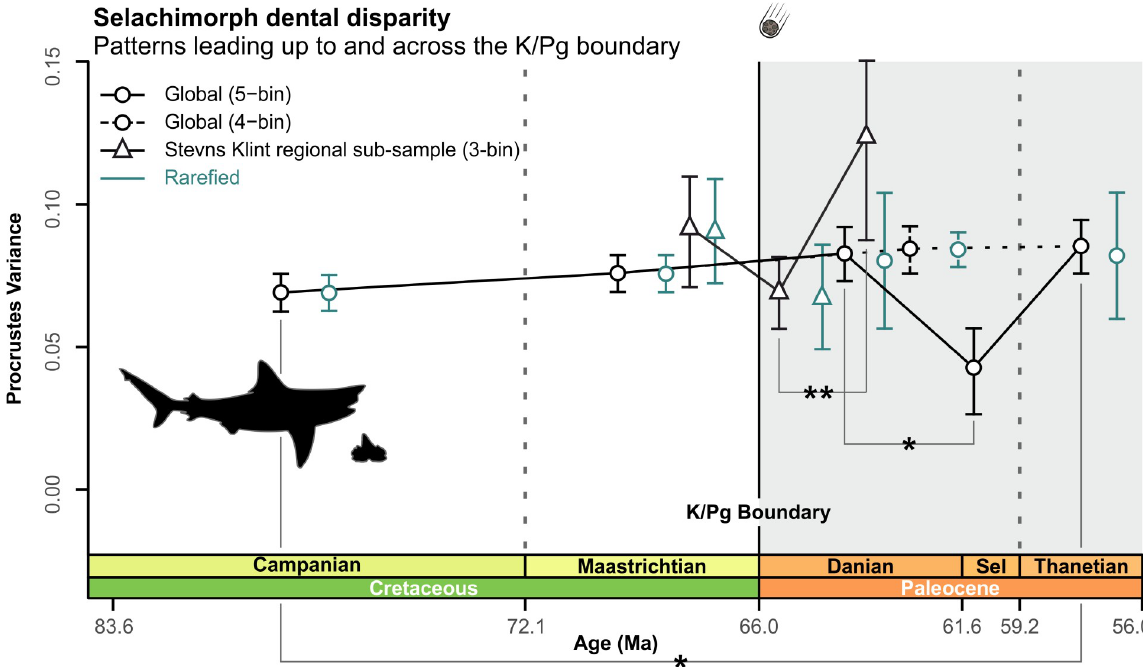
Fig 2. Global and regional level disparity of Selachimorpha. Dental disparity with bootstrapped prediction intervals for the 5- and 4-age time-binning schemes. The 5-age time-binning scheme ( N = 1,156) utilized sample rarefaction on the lowest sampled Selandian time-bin ( N = 28). The 4-age time-binning scheme ( N = 1 198) used the Thanetian ( N = 187). The Stevns Klint regional subsample (3-age time-bin) used the middle Danian ( N = 25). Significant FDR-adjusted p -values for multiple comparisons are indicated ( � p < 0.05, �� p < 0.005).